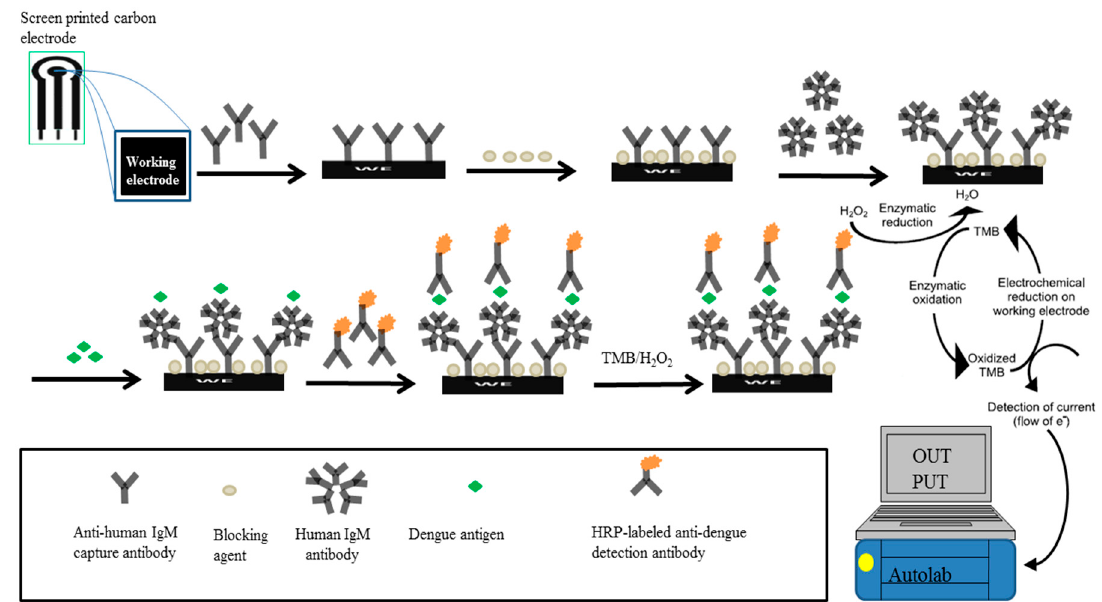
Figure 1. Schematic diagram of the screen printed carbon electrode (SCPE)-based dengue IgM biosensor. The biosensor was constructed by sequentially adding optimised concentration of anti-human IgM capture antibody, blocking agent, human IgM antibody or serum sample, dengue antigen and detection antibody, with washing steps in between. Electrochemical signal was generated following addition of TMB substrate.